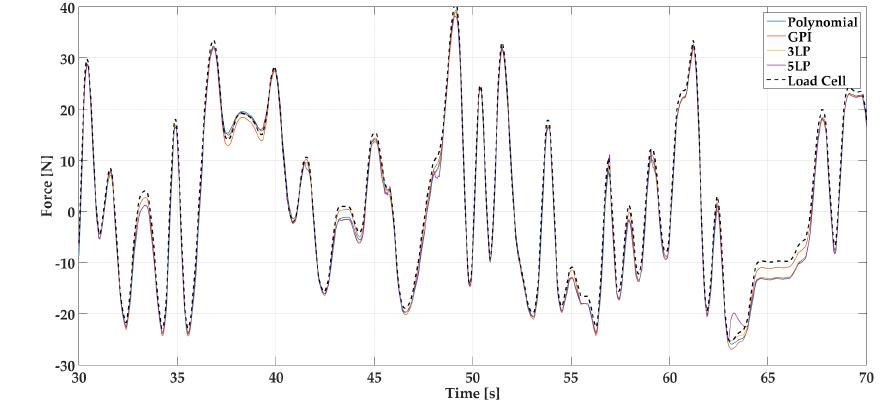
Figure 12. Time response of all fitting models and load cell signal for a 40 s sample of the Random Signal test for PLA based sensor.